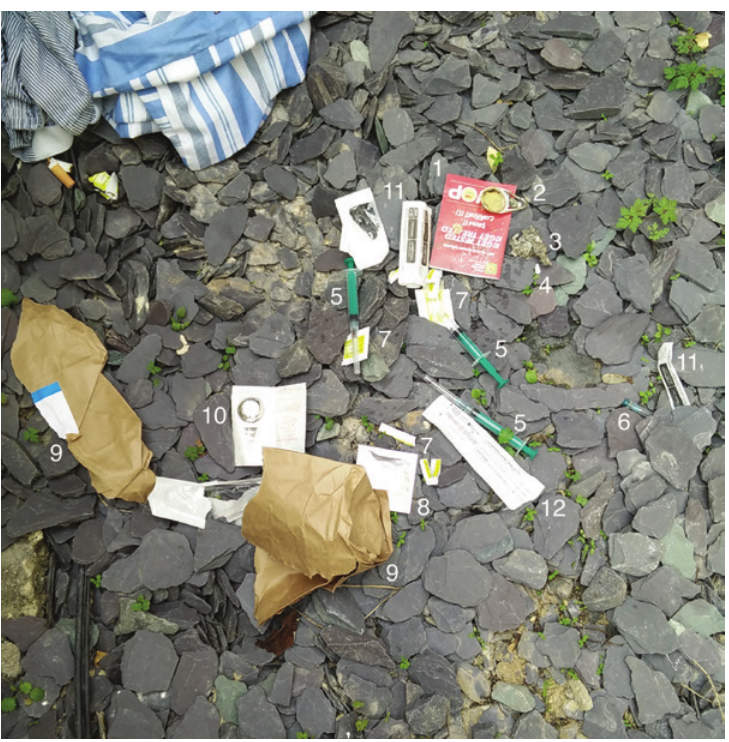
Figure 1 The assemblage as discovered. (Image credit: Gabriel